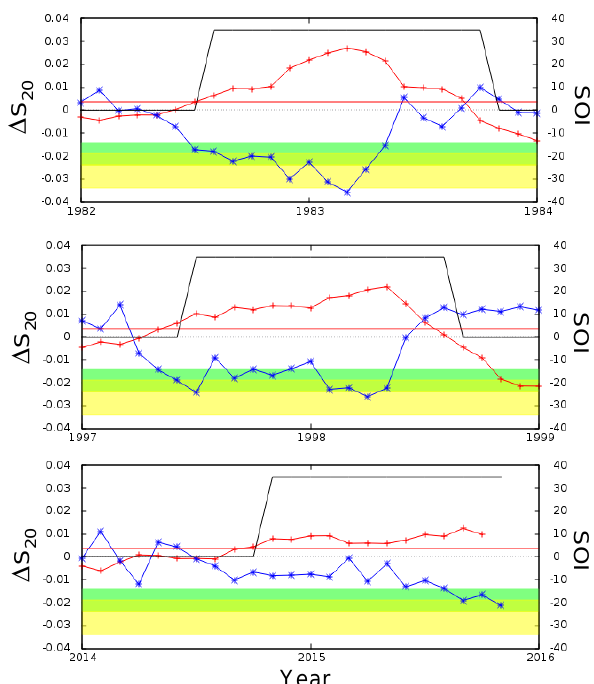
Figure 3. As in Fig. 1, but only for the 1982–1983, 1997–1998 (the two strongest in the last century) and the current 2015–2016 El Niño events.